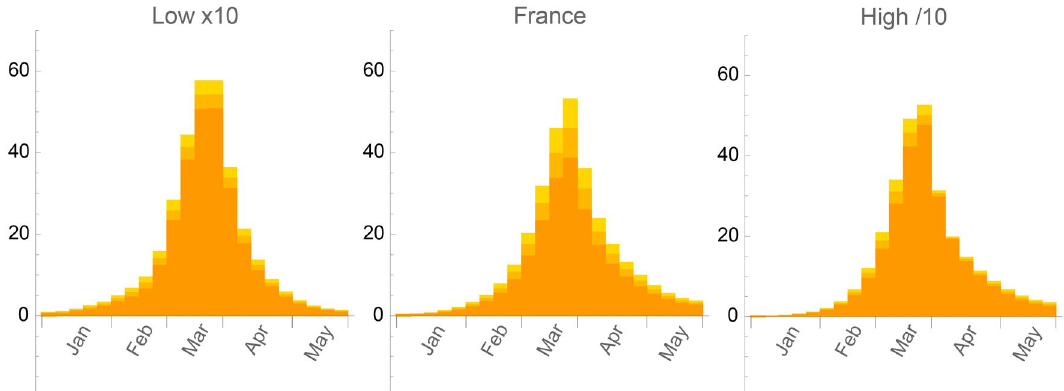
Figure 6. Number of weekly hospital admissions normalized to 50,000 households in France and in two configurations with Low (multiplied by 10), and High (divided by 10) level of social relationships, from left to right respectively, in a typical scenario with no Super Spreading Event, with the same initial conditions and with the same restrictions from the first confinement as in France. Statistical errors at 95% CL are represented by slightly different orange